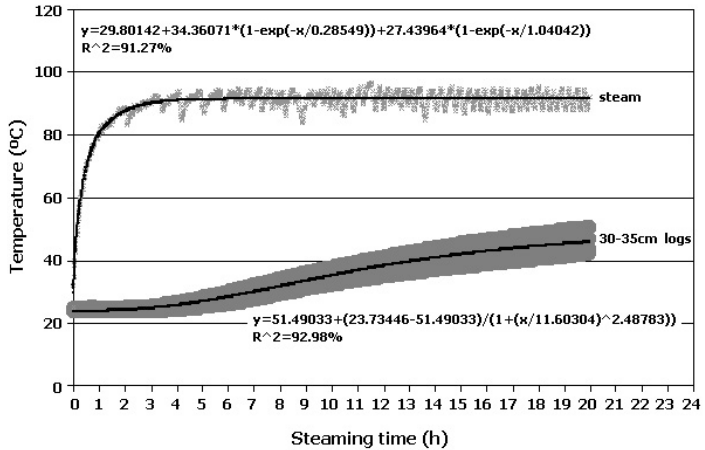
Fig. 4 – Logistics S-shaped curve adjusted for the temperature in the Eucalyptus grandis logs center classified between 30 and < 35 cm diameter during